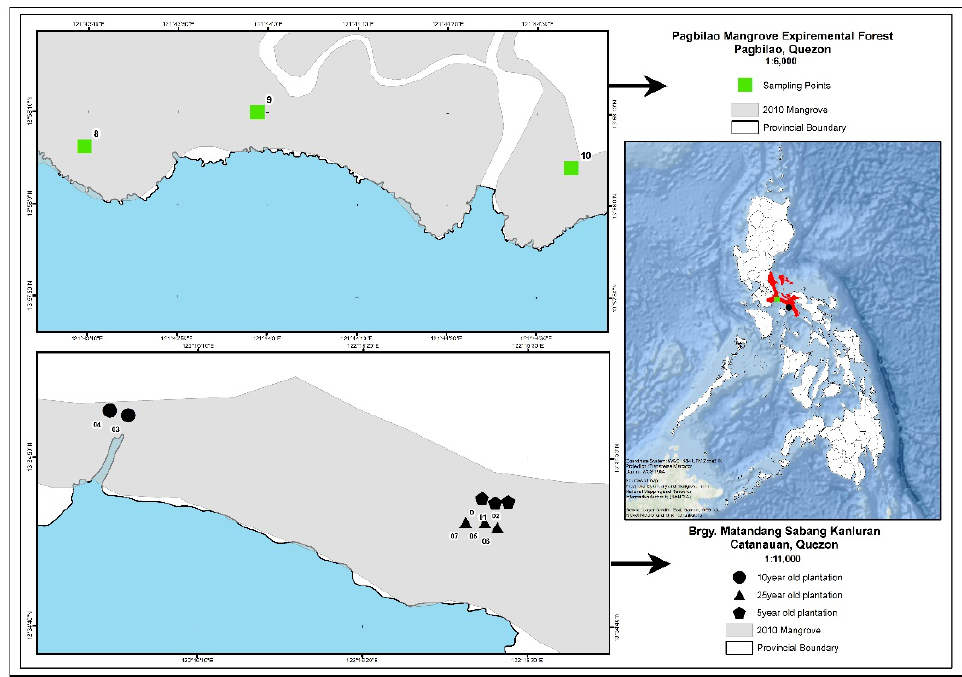
Figure 1. Study sites in Pagbilao and Catanauan, Quezon province, Philippines .